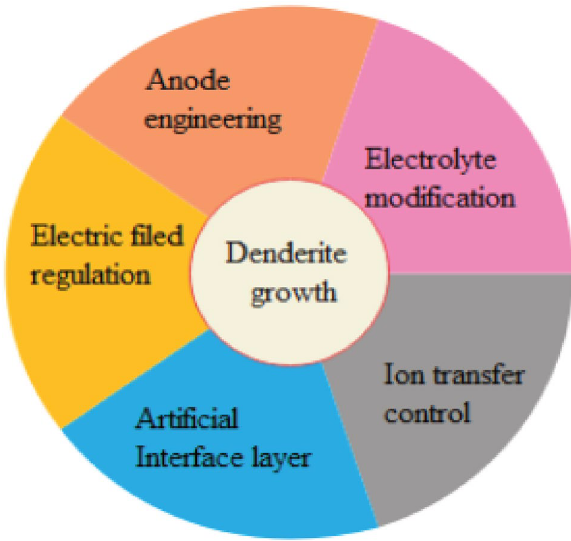
Fig. 2 The schematic view of the methods to inhibit Zn dendrite formation (recently proposed approaches) modified from reference